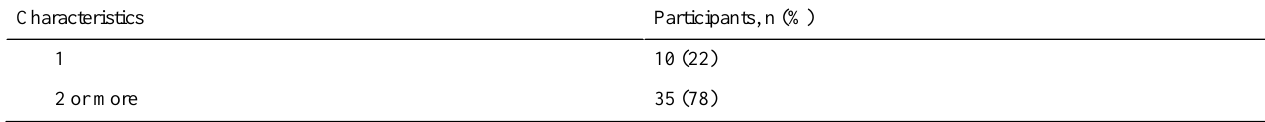
Table 2. Neither the participants’ race/ethnicity ( P =.65) and age ( P =.43) nor any of the substance use behaviors, including frequency of alcohol ( P =.40) or methamphetamine use ( P =.91) or any cocaine ( P =.28), crack ( P =.99), or polysubstance use ( P =.24), were significantly associated with the completion